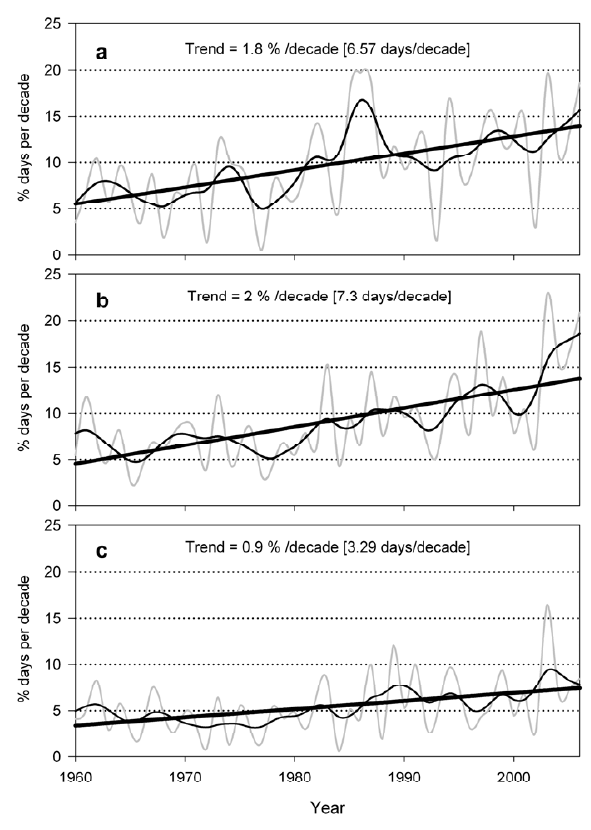
Figure 6. Temporal evolution and trends in warm nights (TN90p) time series at three Fig. 6. Temporal evolution and trends in warm nights (TN90p) time different observatories: (a) Blanes (Mediterranean station), (b) airport of Bilbao series at three different observatories: (a) Blanes (Mediterranean (Cantabrian station), and (c) airport of Zaragoza (mainland station). The solid line station), (b) Bilbao airport (Cantabrian station), and (c) airport of represents the linear regression. The thin black line represents a 7-year running Zaragoza (mainland station). The solid line represents the linear mean. regression. The thin black line represents a 7-yr running